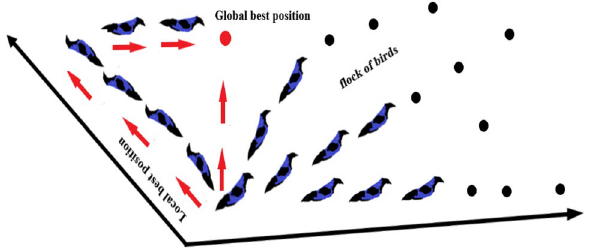
Figure 5. The flock of birds in their random movement for the best optimal position search.